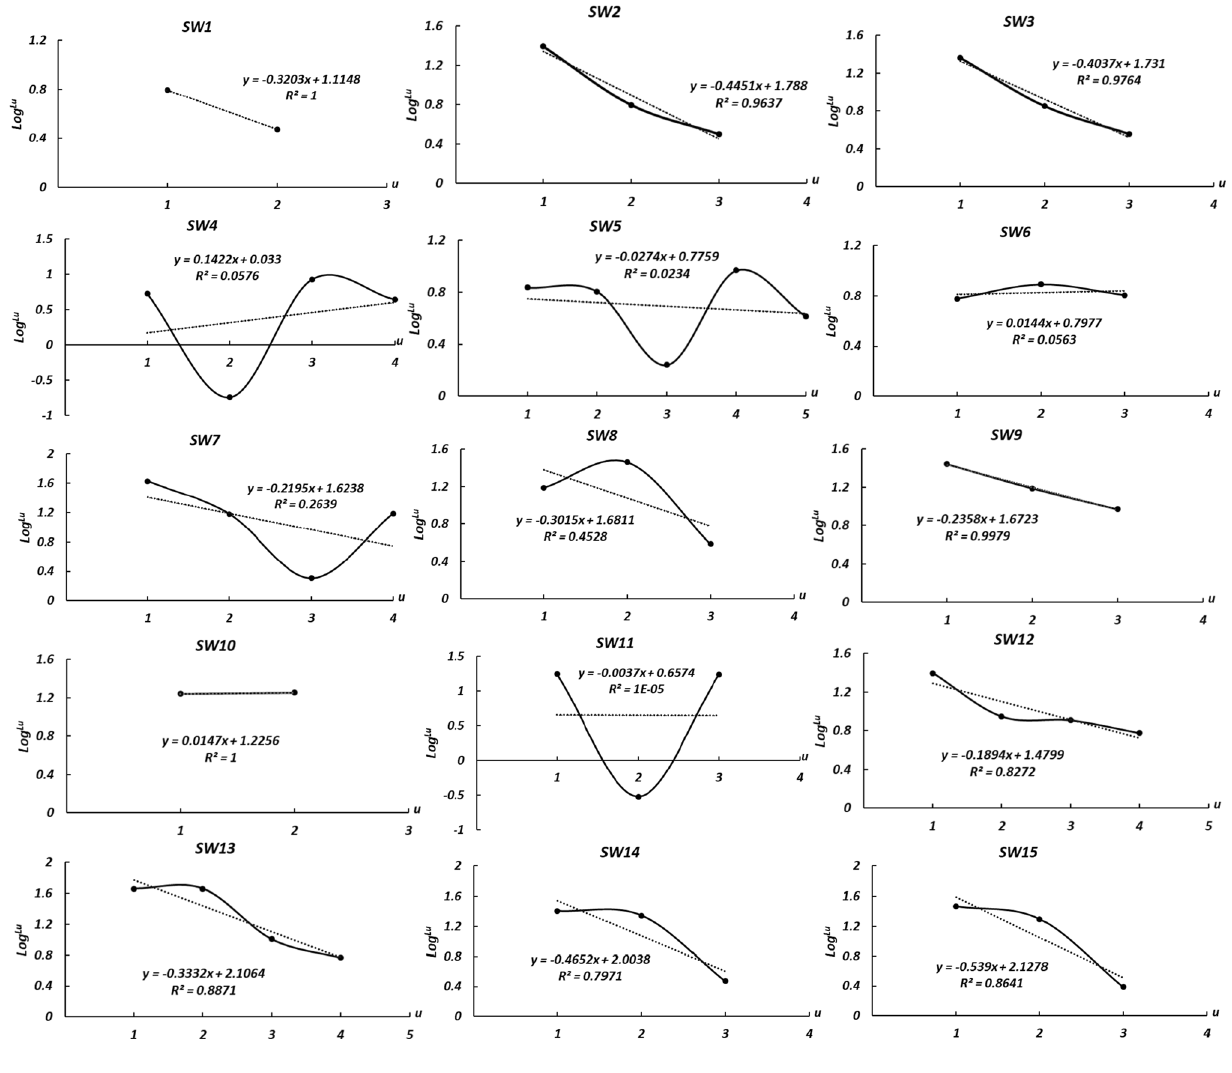
Fig. 5 Regression of L